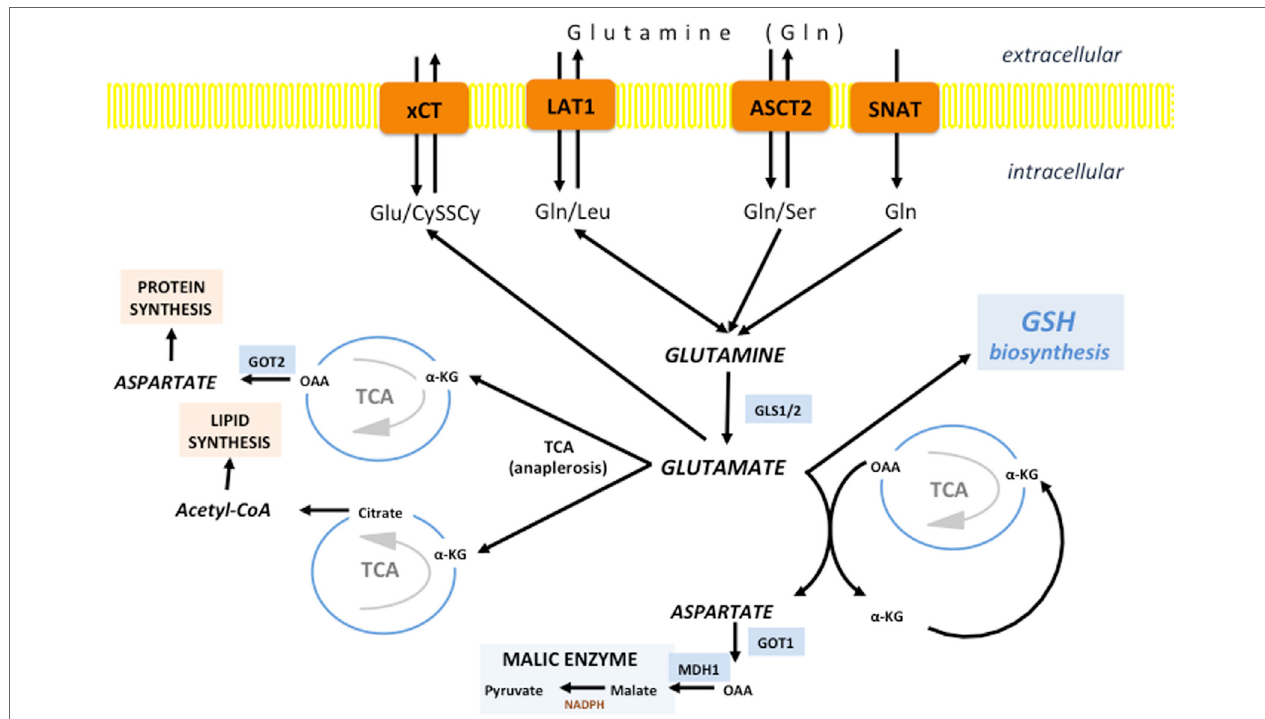
FiGURe 5 | Glutamine/glutamate fates in cancer cells. Different transporters are proposed to fuel the “Glutamine addiction” of cancer cells including alanine-serine- cysteine transporter 2 (ASCT2), SNAT1/2, and L-type amino acid transporter 1 (LAT1). Once inside the cell, Gln can be use for uptake of essential AAs by LAT1. However, the vast majority of Gln is promtly deaminated to glutamate by the action of cytoplasmic or mitochondrial glutaminase (GLS1 and GLS2, respectively). If deaminated in cytosol, Glu is transferred into mitochondria, and there it is further converted into α -ketoglutarate ( α -KG) to replenish the tricarboxylic acid (TCA). However, the fate of α -KG can be dual. It can follow normal TCA flow until oxaloacetate (OAA), which is then converted into asparate by aspartate dehydrogenase (GOT2) and translocated into cytoplasm or used for synthesis of asparagine and arginine (protein synthesis). However, if the α -KG is carboxylated to isocitrate and then converted into citrate, citrate is exported into the cytosol where it is used for lipid synthesis in the form of acetyl-CoA. Glutamate-derived aspartate can also be converted into OAA by cytoplasmic GOT1, commonly induced in KRAS-mutated tumors. OAA is then converted first into malate by malate dehydrogenase 1 (MDH1) and then into pyruvate by malic enzyme (ME), generating reducing power in the form of NADPH. Besides involvement in anaplerosis and NADPH production, Glu has an important role as a component of GSH, as well as a substrate for system x c -light chain (xCT) in allowing entrance of cystine into the